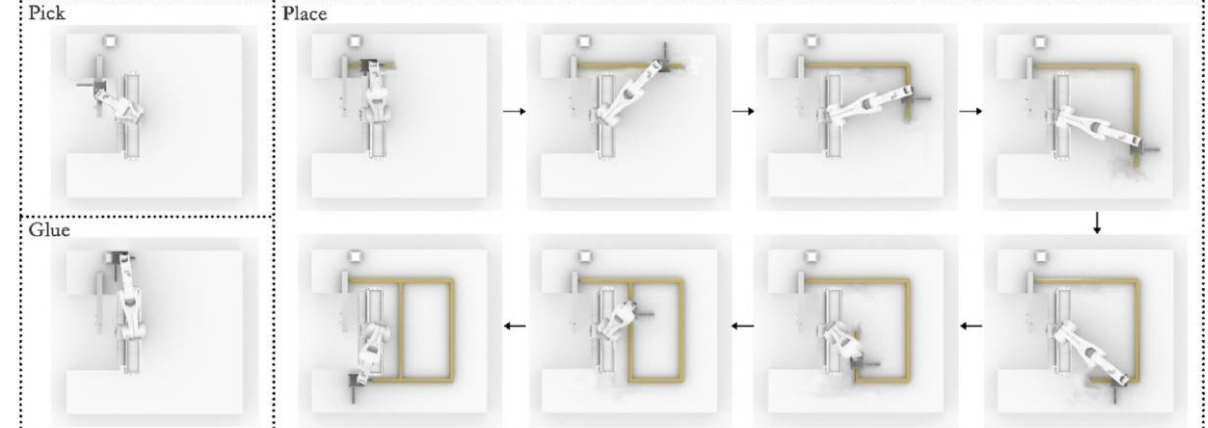
Figure 7. Snapshot of the process of building one unit by the robot.